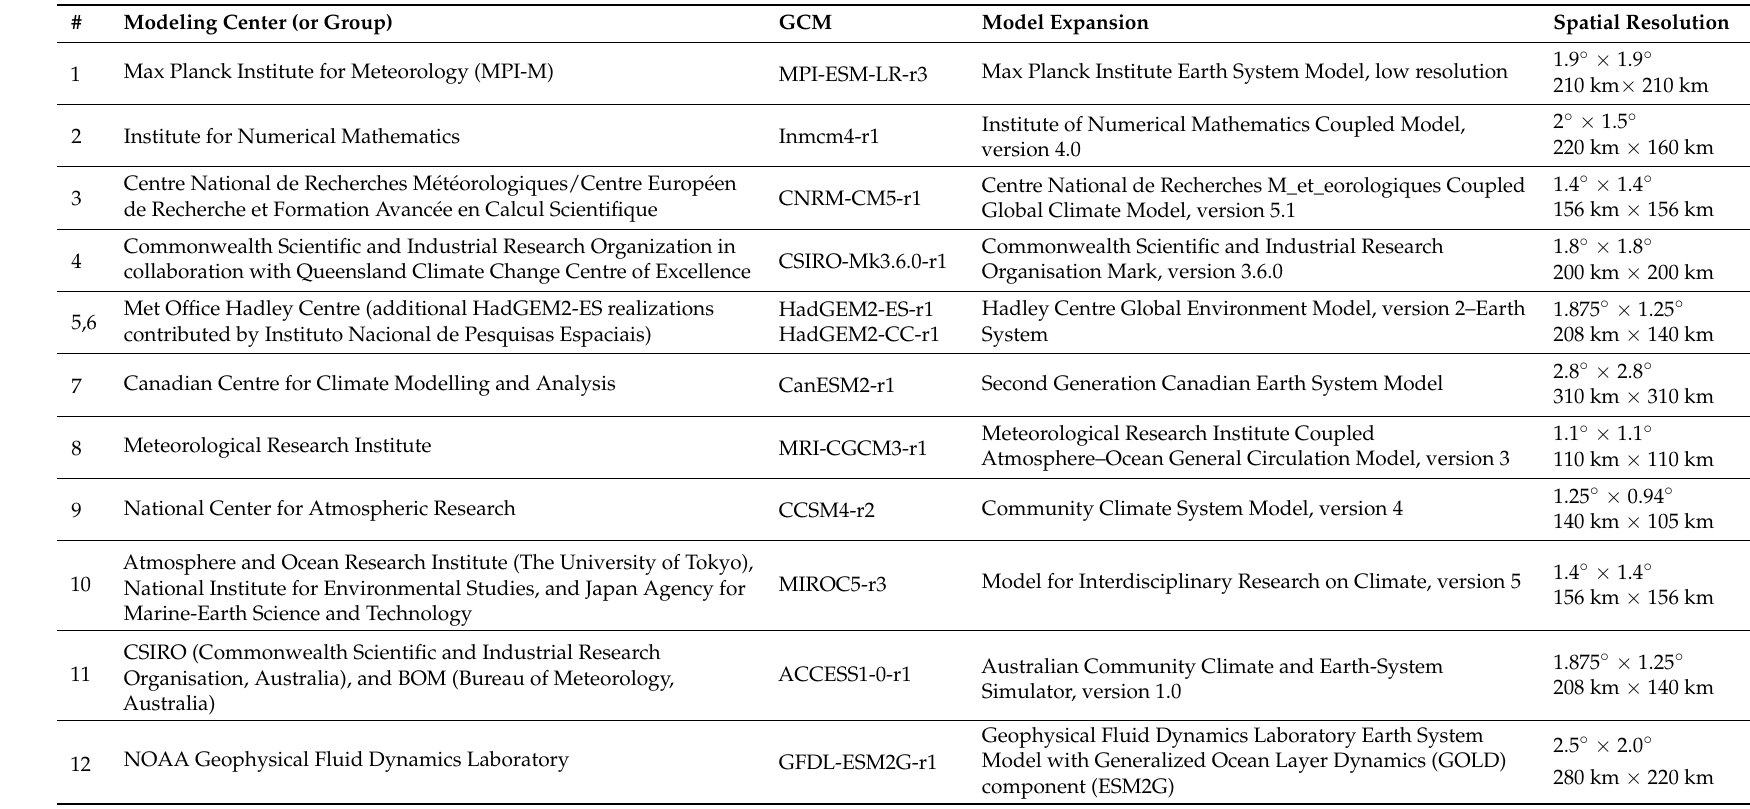
Table 2. GCMs used in this study and their modeling group